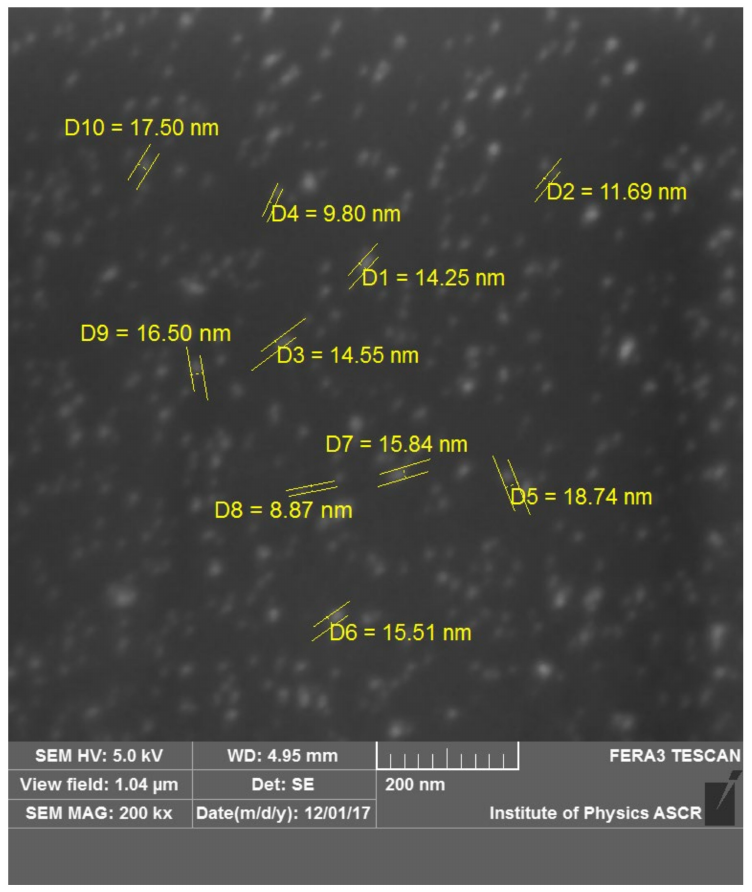
Figure 4. SEM image of Ag NPs on a Si substrate, deposited at a target–orifice distance of 200